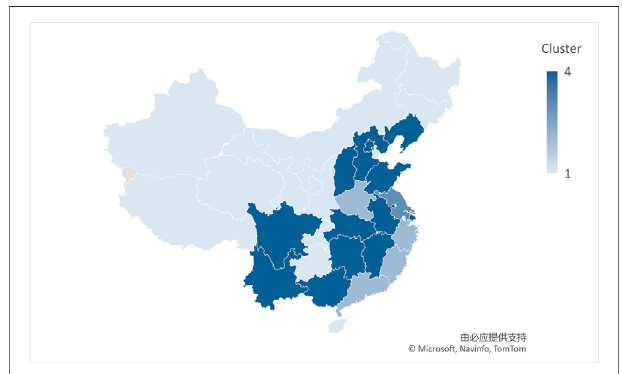
FIGURE 5 | K-means clustering result by K (cid:1)